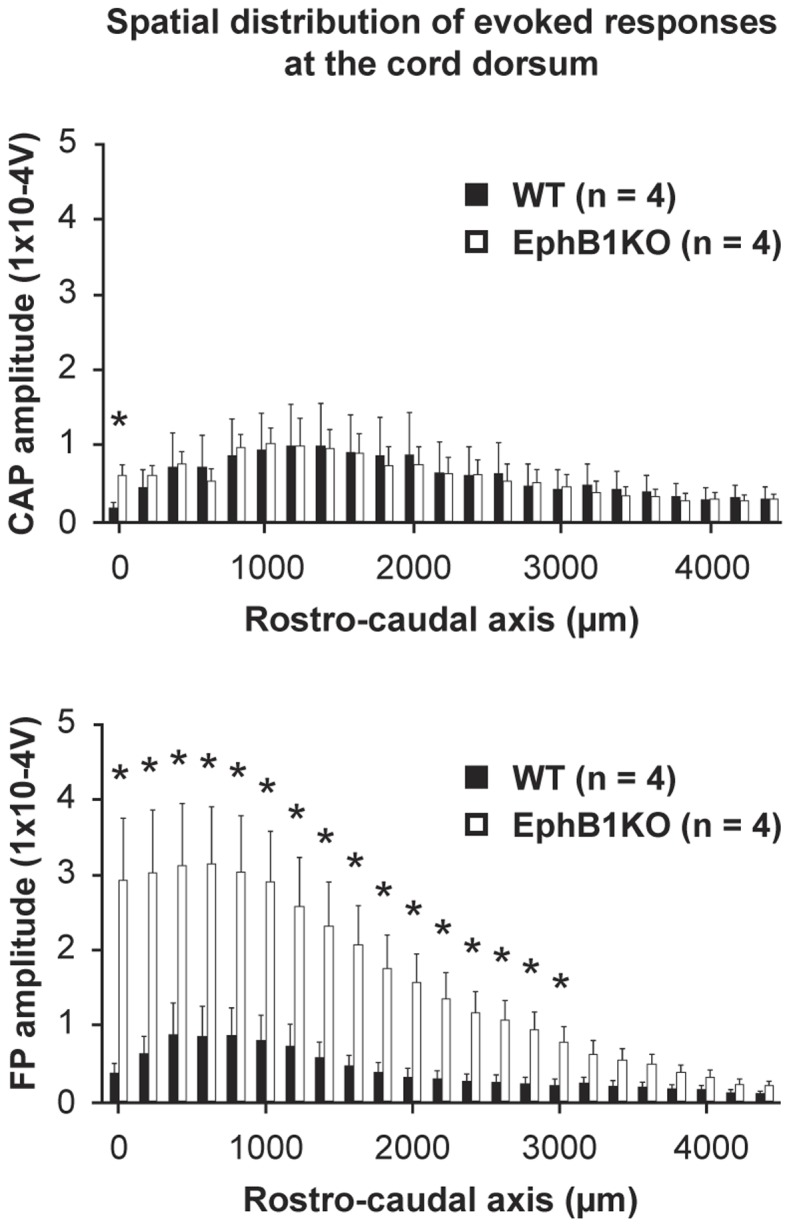
EphB1 KO mice display enhanced A-fibre evoked field potentials along the cord dorsum.Electrical stimulation of the central end of the cut sural nerve at 5T typically evoked a synchronous triphasic compound action potential (CAP), followed by a negative field potential (FP) at the root entry zone. Recordings were made systematically along the rostro-caudal axis 200 µm apart. At each site, 20 successive responses were averaged and the amplitudes (Voltsx10-4) plotted as a function of their rostro-caudal distribution. CAP values were normalised (amplitude and distribution) so allowing comparison of resulting FPs to inputs of similar strengths. Top and bottom panels respectively show the spatial distribution of the CAP and FP amplitudes, with the mean evoked-potentials at each successive position indicated by the paired histograms (WT: filled column; EphB1KO: empty column). While no statistical difference was found between genotypes in the amplitude of the evoked-CAPs (mixed design two-way ANOVA, between factors, p>0.05), the distribution of the evoked-FPs (bottom panel) along the rostro-caudal axis of the cord was significantly different between WT and EphB1KO mice (between factors, p<0.001), indicating that knocking out the EphB1 gene produced profound alterations in the amplitude of Aβ/Aδ fibre-mediated synaptic responses of the dorsal horn neurones in EphB1KO mice. For both types of evoked-potentials, a significant effect (p<0.001) was present for the within factor (level of the spinal cord) indicating that they differ along the rostro-caudal axis of the cord within each genotype. As indicated (stars), post-hoc analysis (independent t -test or non-parametric Mann-Whitney rank sum test) showed that, while it is only the case at the first rostral position for the CAPs, the majority of the FPs were significantly different between the two genotypes (p<0.05), except for the most caudal sites (3200 to 4000 µm) where the signals appeared greatly reduced both for WT and EphB1KO mice.